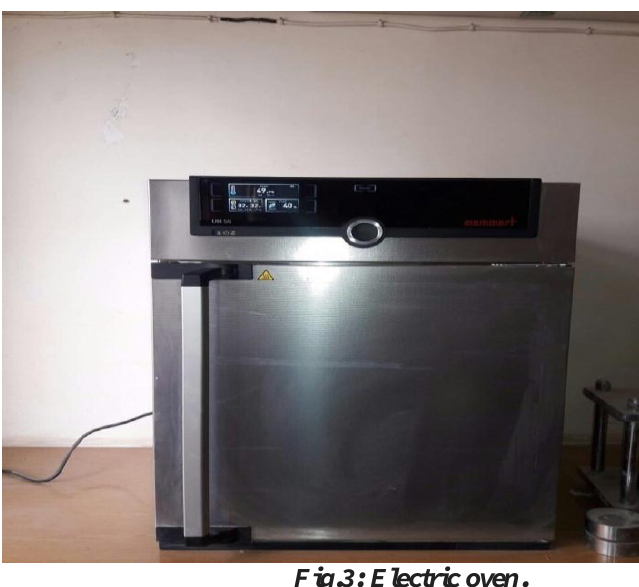
Fig.3: Electric oven.